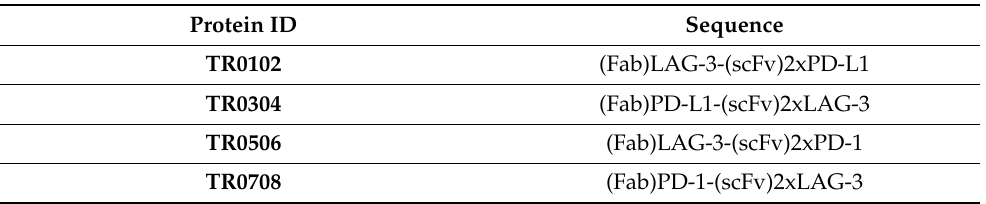
Table 1. List of the novel generated tribodies and their composition of scFvs and Fabs derived from immunomodulatory mAbs.